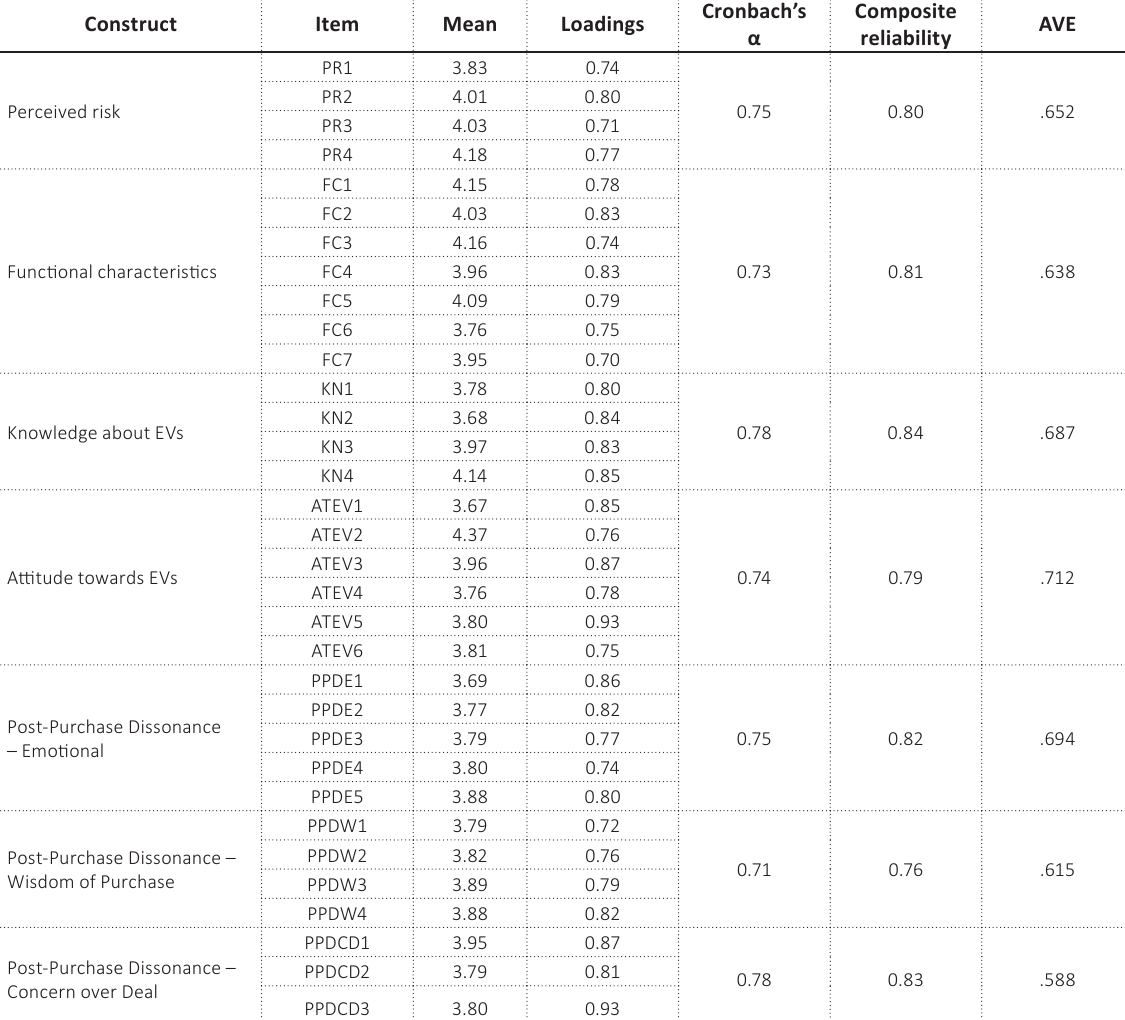
Table 2. Mean, loadings, composite reliability, and average variance extracted Construct